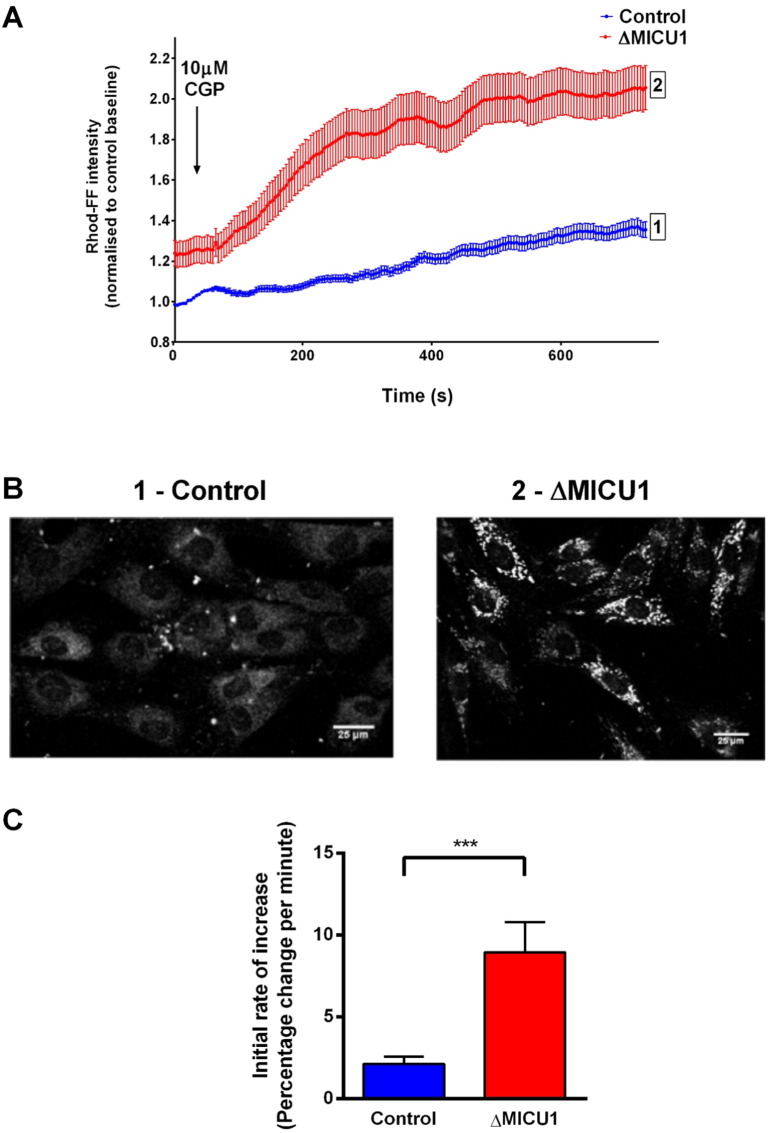
Effect of blocking the NCLX on mitochondrial Ca2+ uptake.(A) Representative traces of one experimental day, after normalising each time point to the resting rhod-FF intensity of the control.(B) Representative confocal images of galactose-cultured, rhod-FF loaded control [1] and ΔMICU1 [2] fibroblasts after approximately 7 mins of 10 μM CGP-37157 incubation.(C) The initial rate of increase was analysed as percentage change per minute over the first 2 min, after normalising to baseline of each cell.n > 100 cells from 3 independent experiments (***P ≤ 0.001).